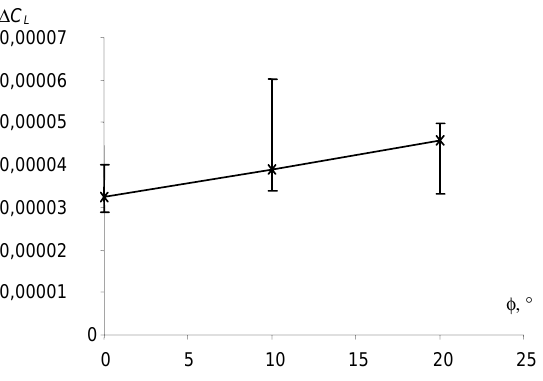
Fig 3 . Relative calculation error of wing lift force coefficient dependence on wing sweep. NACA4415 wing Re=2,1 × 10 6 ,